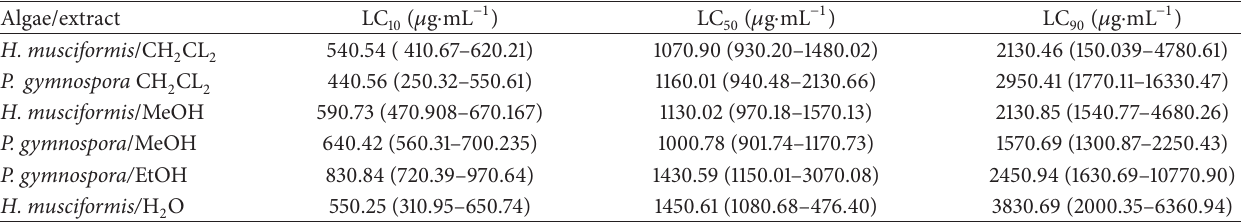
Values in parentheses correspond to the confidence